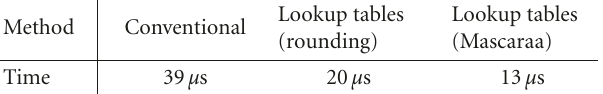
Table 2: CIR processing time optimization. Table 3: Comparison of computational e ff ort between di ff erent fil- tering